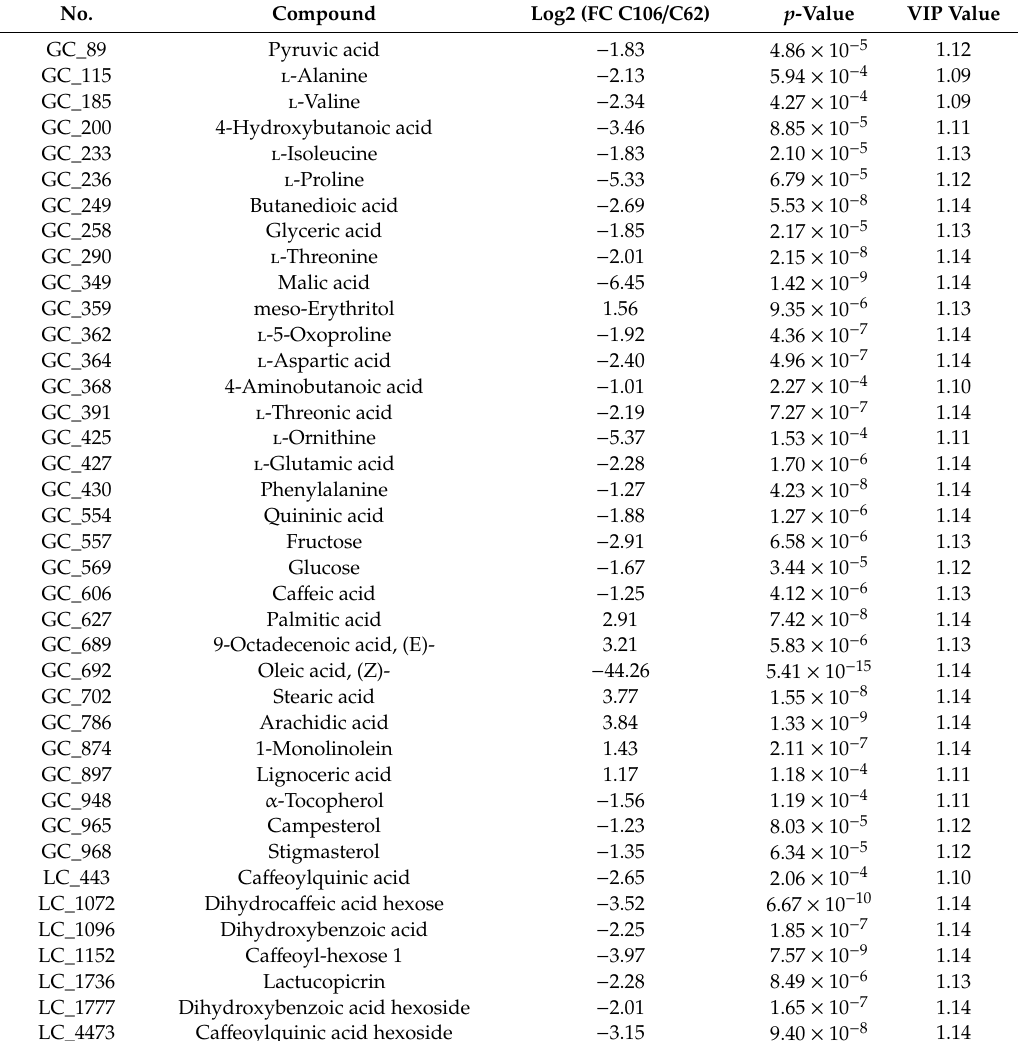
Table 2. Di ff erential metabolites extracted from germinated buds of S15k0106 (C106) and S13k0062 (C62)